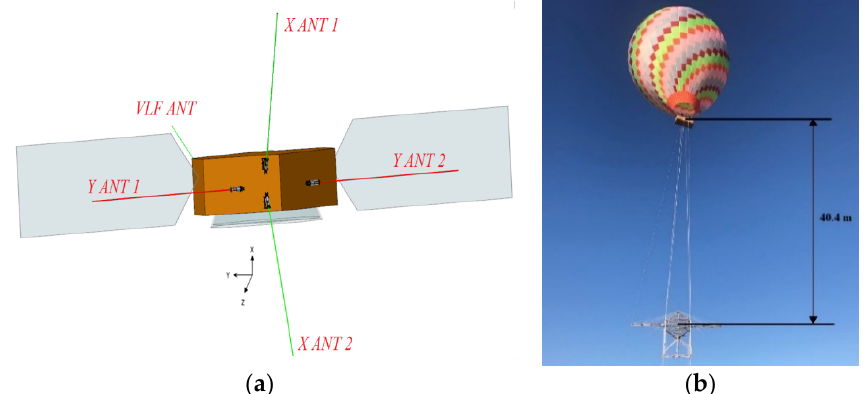
Figure 2. ( a ) Install location diagram of cross dipole antennas. Cross-dipole antennas are deployed in the +Z plane of the spacecraft. Therefore, the antenna plane is always directed toward Mars. ( b ) Hanging way of MOSIR and orbiter model, the distance between orbiter model and the balloon is 40.4 m. The wooden bracket is convenient for taking off and landing.